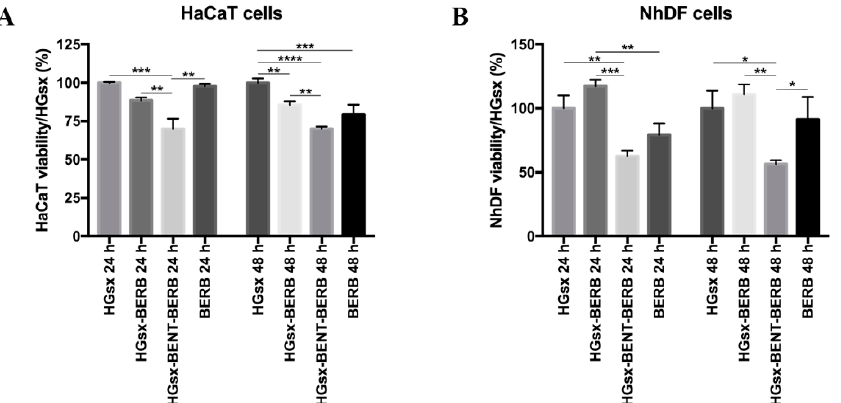
Figure 4. XTT assay. HaCaT ( A ) and NhDF ( B ) cells were treated with HG sx , HG sx -BERB, HG sx - BENT-BERB conditioned media and medium with 50 µM Berberine. (* p ≤ 0.05; ** p ≤ 0.01; *** p ≤ BERB conditioned media and medium with 50 µ M Berberine. (* p ≤ 0.05; ** p ≤ 0.01; *** p ≤ 0.001; 0.001; **** p ≤ 0.0001) . **** p ≤